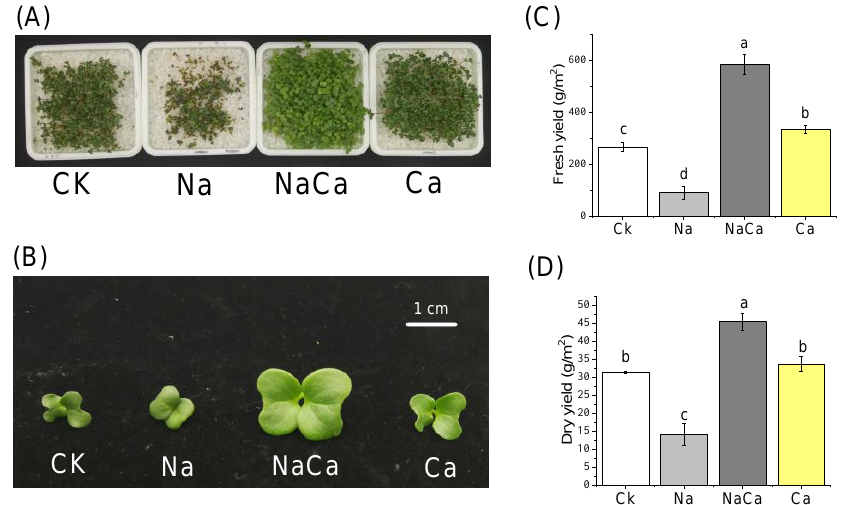
Figure 1. Fresh yield and dry yield of broccoli microgreens under different treatments. ( A ) Trays of microgreens under different treatments; ( B ) Leaves of microgreens under different treatments; ( C ) Fresh yield of microgreens under different treatments; ( D ) Dry yield of microgreens under different treatments. CK, distilled water; Na, 80 mmol/L NaCl; NaCa, 80 mmol/L NaCl + 1.39 mmol/L CaSO 4 ; Ca, 1.39 mmol/L CaSO 4 ; scale bar = 1 cm. Data are expressed as the mean ± standard deviation (SD), values labelled with different letters are significantly different (p < 0.05).